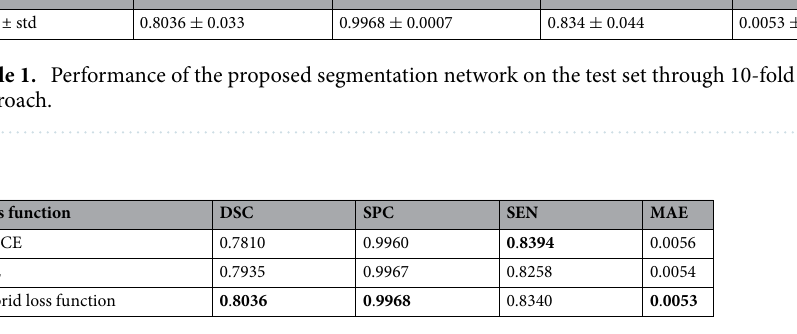
Table 2. Quantitative evaluation of our proposed model trained with different loss functions. The presented results are the average of the obtained results through a 10-fold cross-validation process. Significant values are in